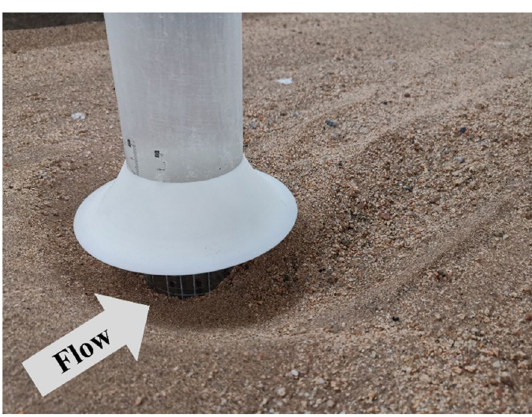
Fig. 6 Scour hole appearance of case 7